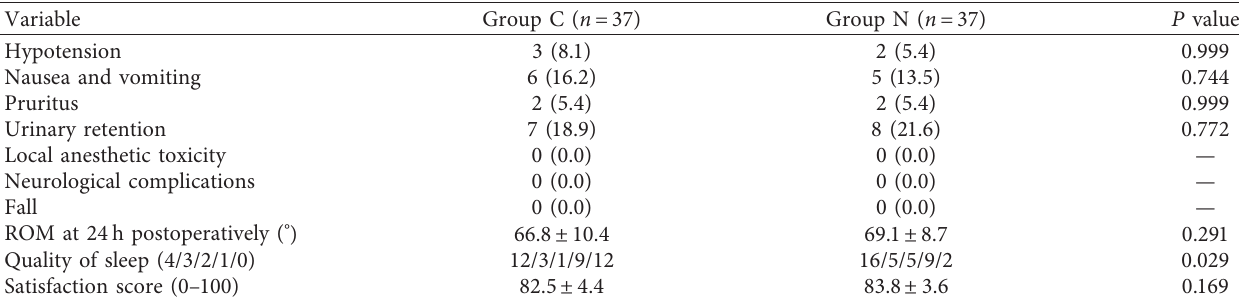
Figure 3: Strength of quadriceps in the operative knee at different time points before and after the operation. kgf: kilograms of force. Table 3: Complications, ROM, sleep quality, and satisfaction score following the